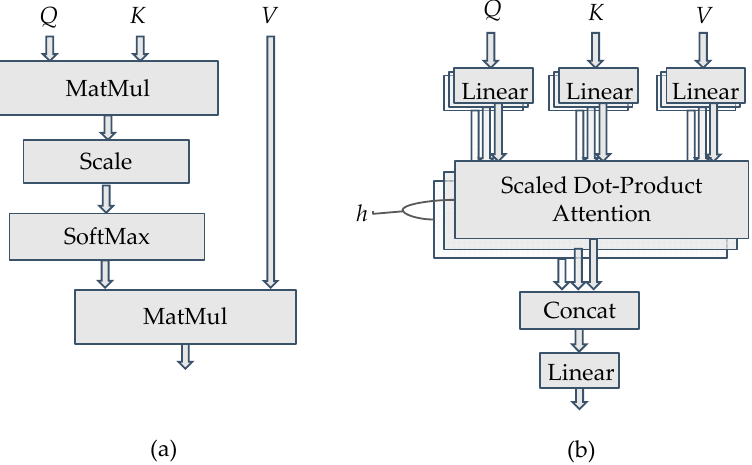
Figure 1. ( a ) The scaled dot-product attention block, and ( b ) the multi-attention block.